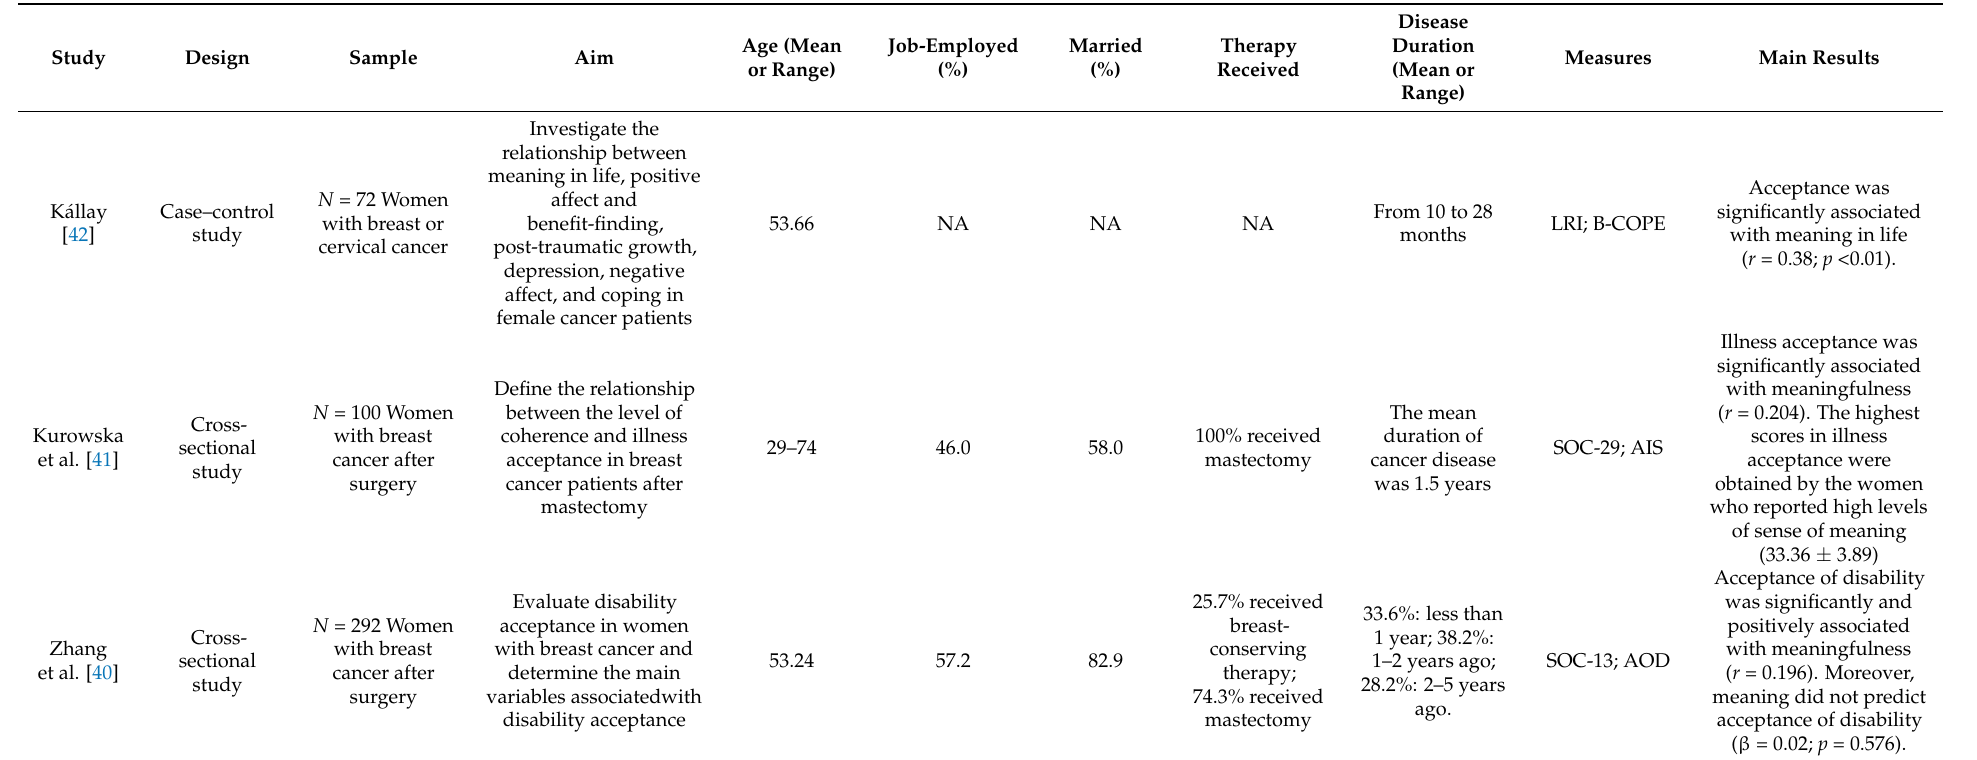
Table 1. Studies included in the systematic